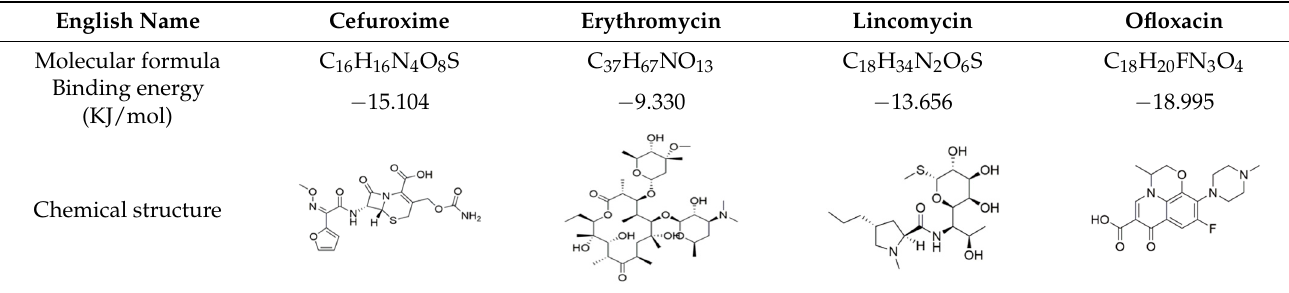
Table 1. The chemical structure, molecular formula and binding energy of the potential inhibitors of SARS-CoV-2 with AutoDock method.